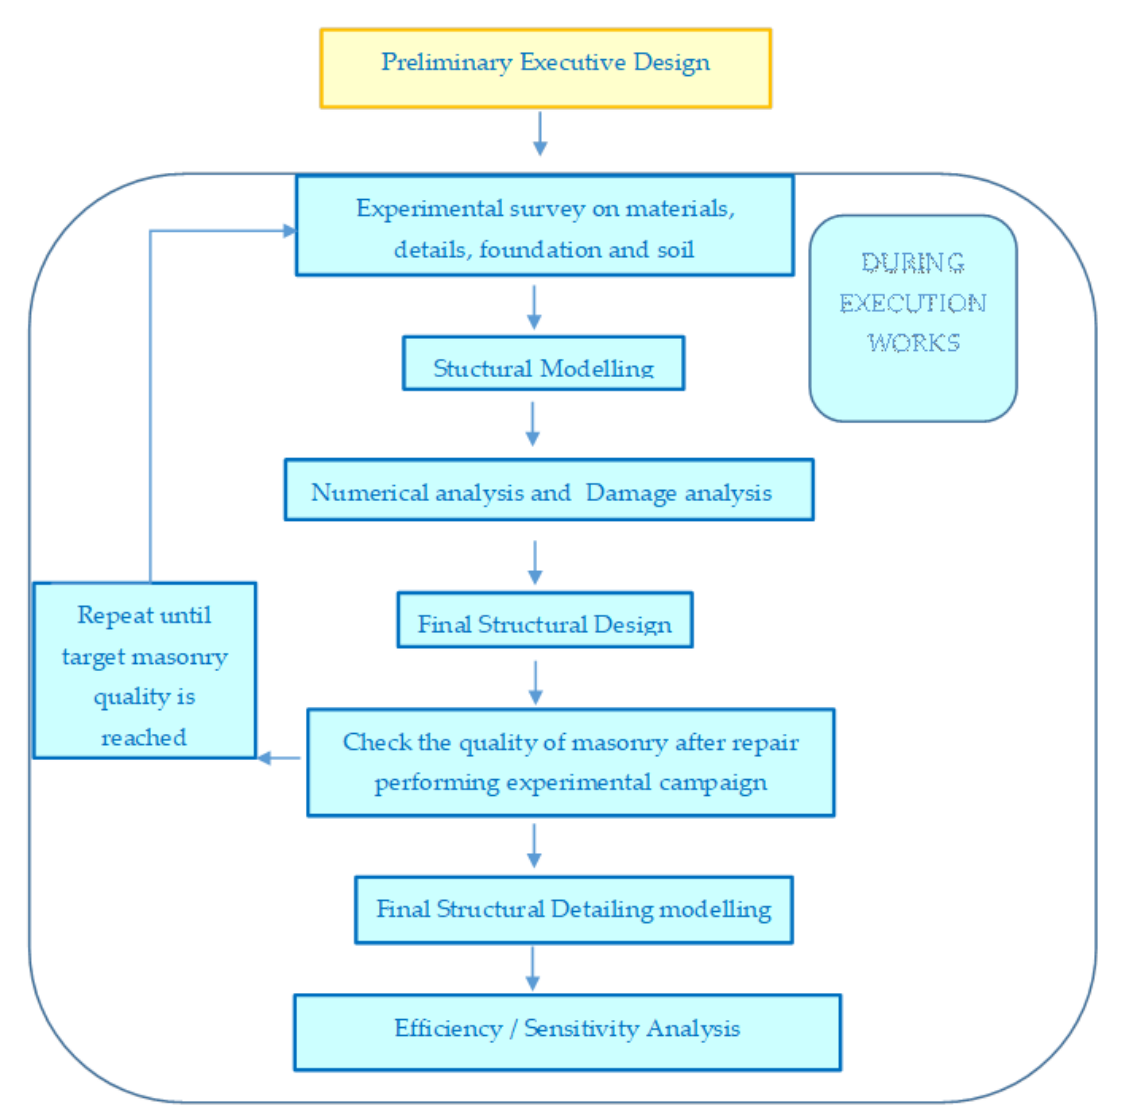
Figure 2. Design procedure on masonry structures at archaeological